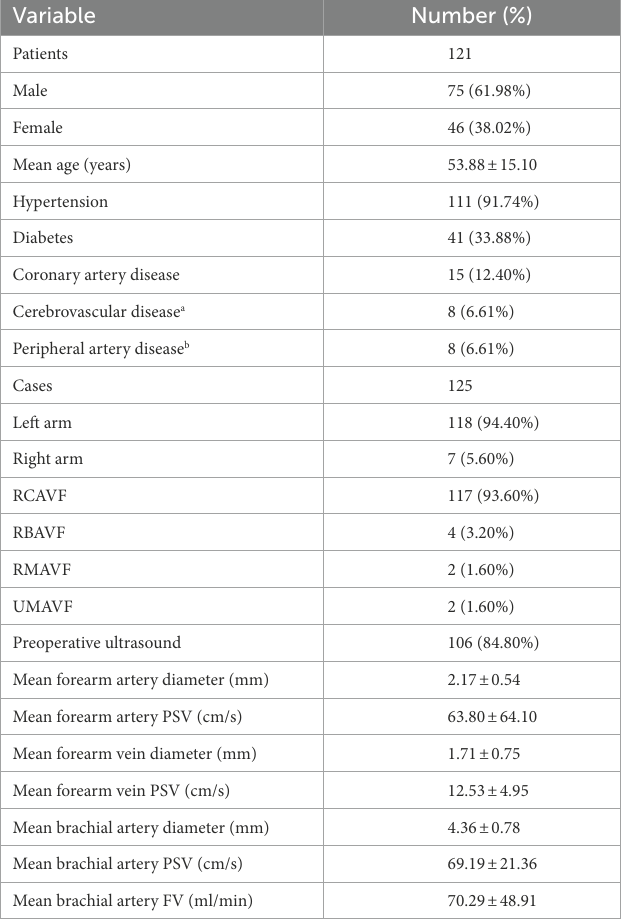
TABLE 1 Patients’ demographic characteristics, ultrasound data, and surgical strategy.